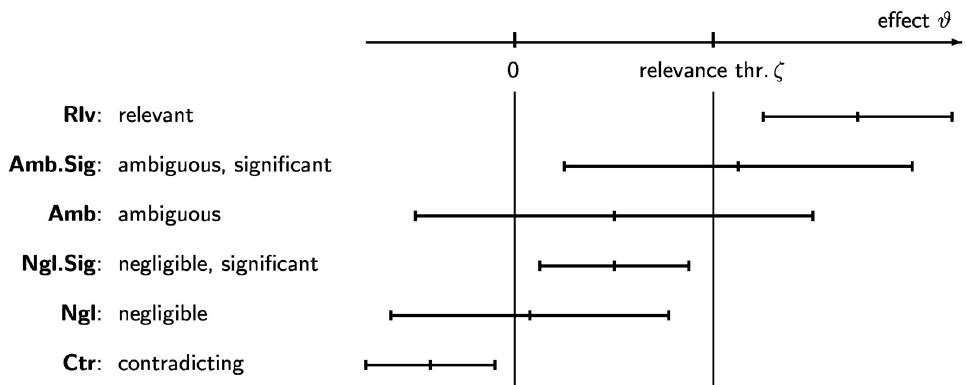
Fig 2. Classification of cases based on a confidence interval and a relevance